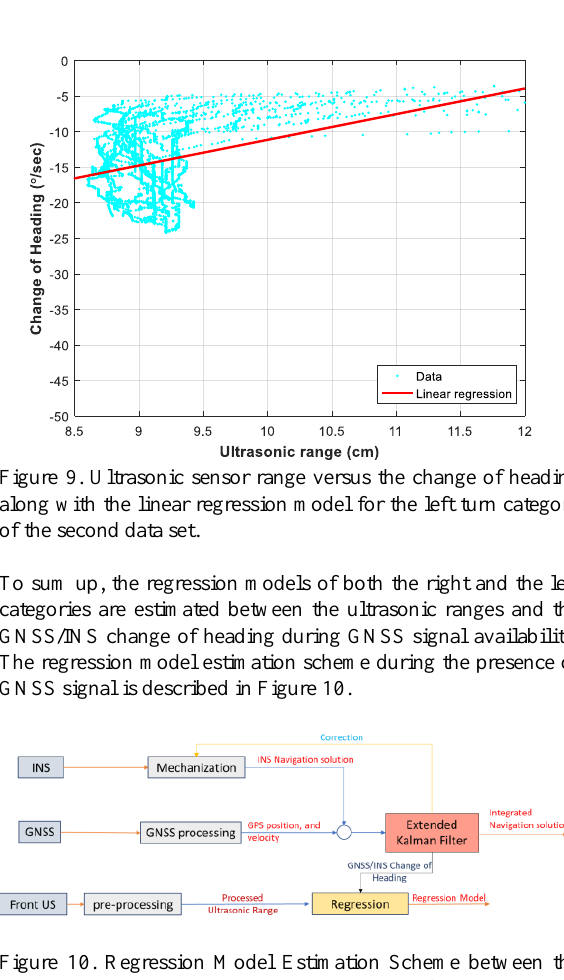
Figure 13. Ultrasonic range versus the estimated change of heading for the left turns